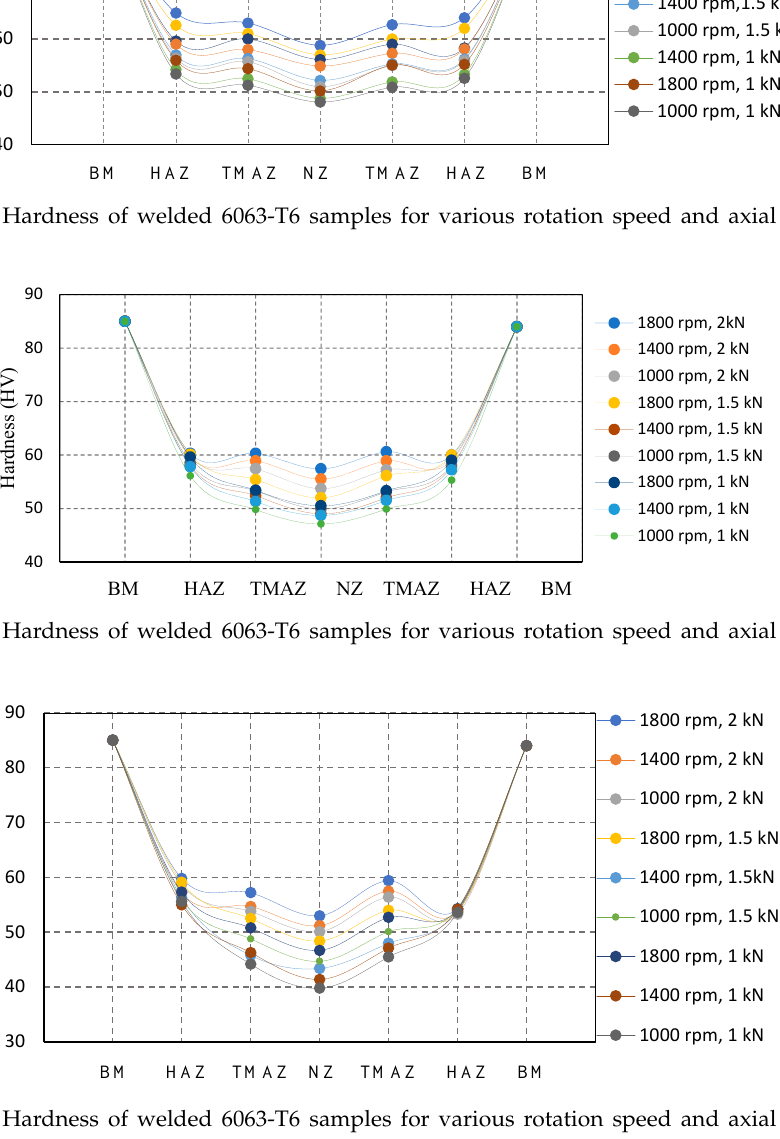
Figure 12. Hardness of welded 6063-T6 samples for various rotation speed and axial force (TS: 10 mm/min).